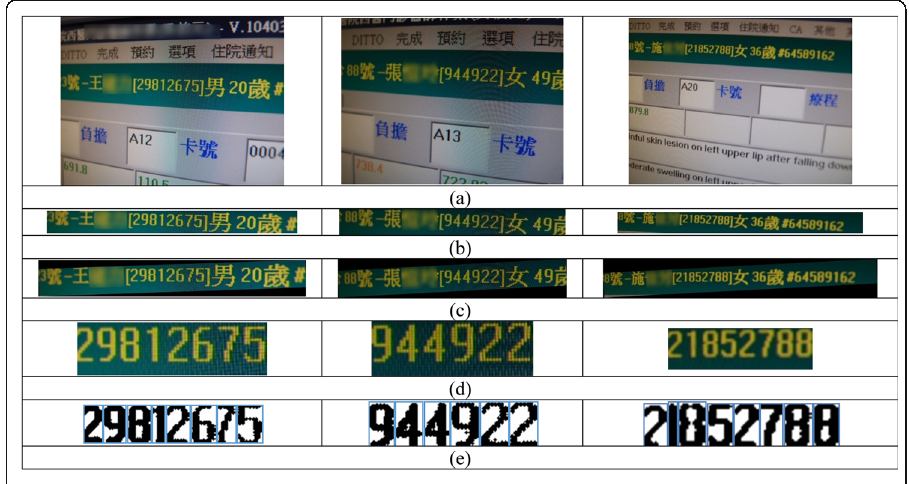
Fig. 4 Results of the proposed scheme a pre-processing, b initial ROI cropping, c skew correction, d candidate region refinement, and e digit